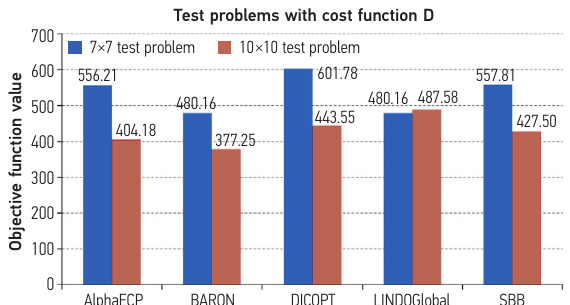
Fig. 5. Objective function values for test problems with cost function D